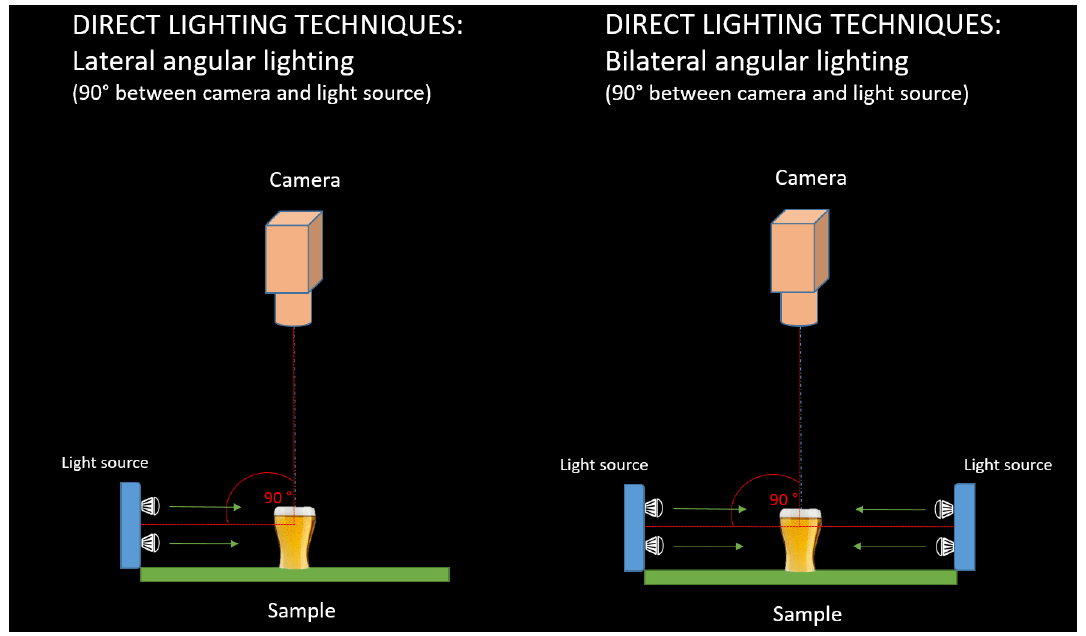
Figure 6. Lateral lighting techniques.